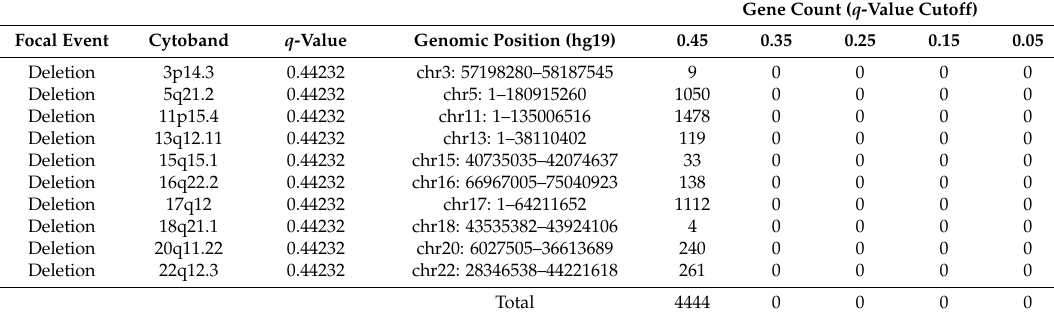
Table 8. List of regions and their associated genes located in the most common sections of recurrent DNA CNAs, derived from analysis conducted involving low grade samples (grades I and II). Gene Count ( q -Value